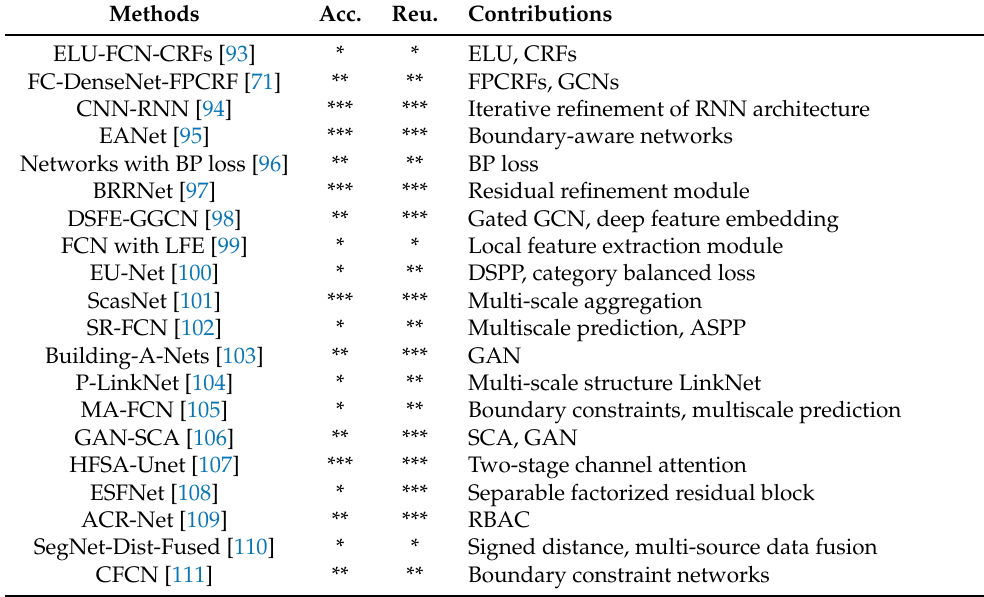
Table 1. Cont . Methods